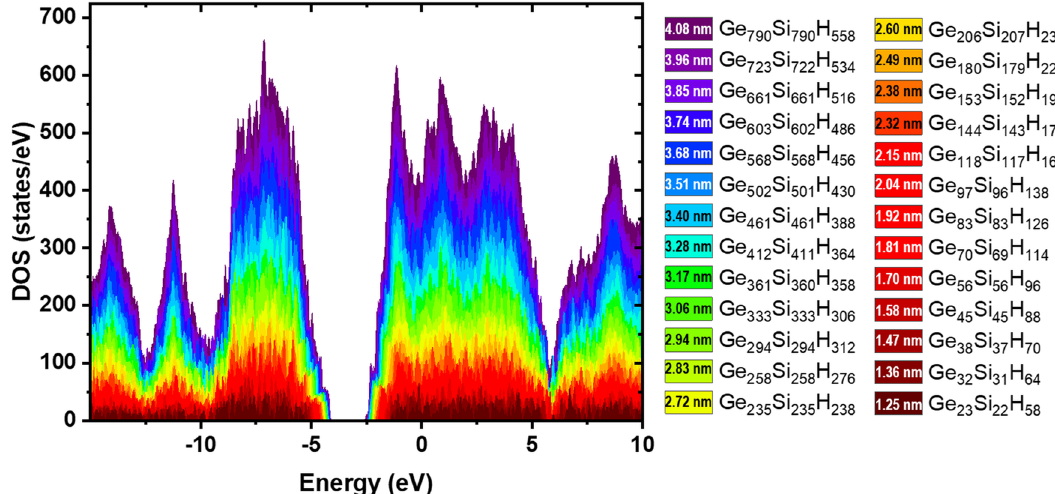
Figure 6. DOS for H-passivated spherical Ge 0.5 Si 0.5